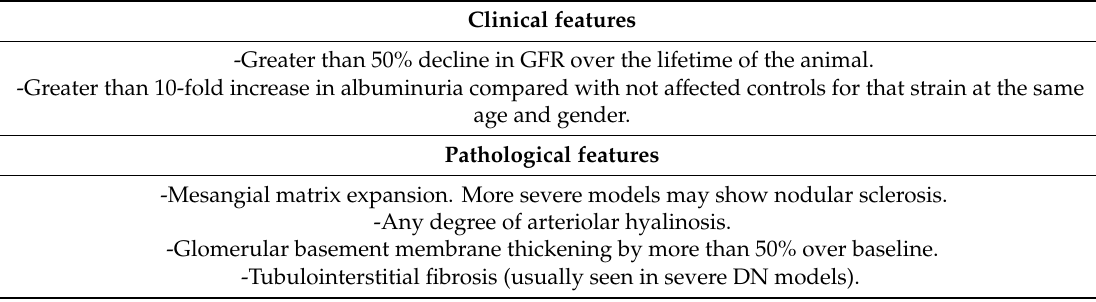
Table 1. Characteristics of acceptable animal models with diabetic kidney disease established by